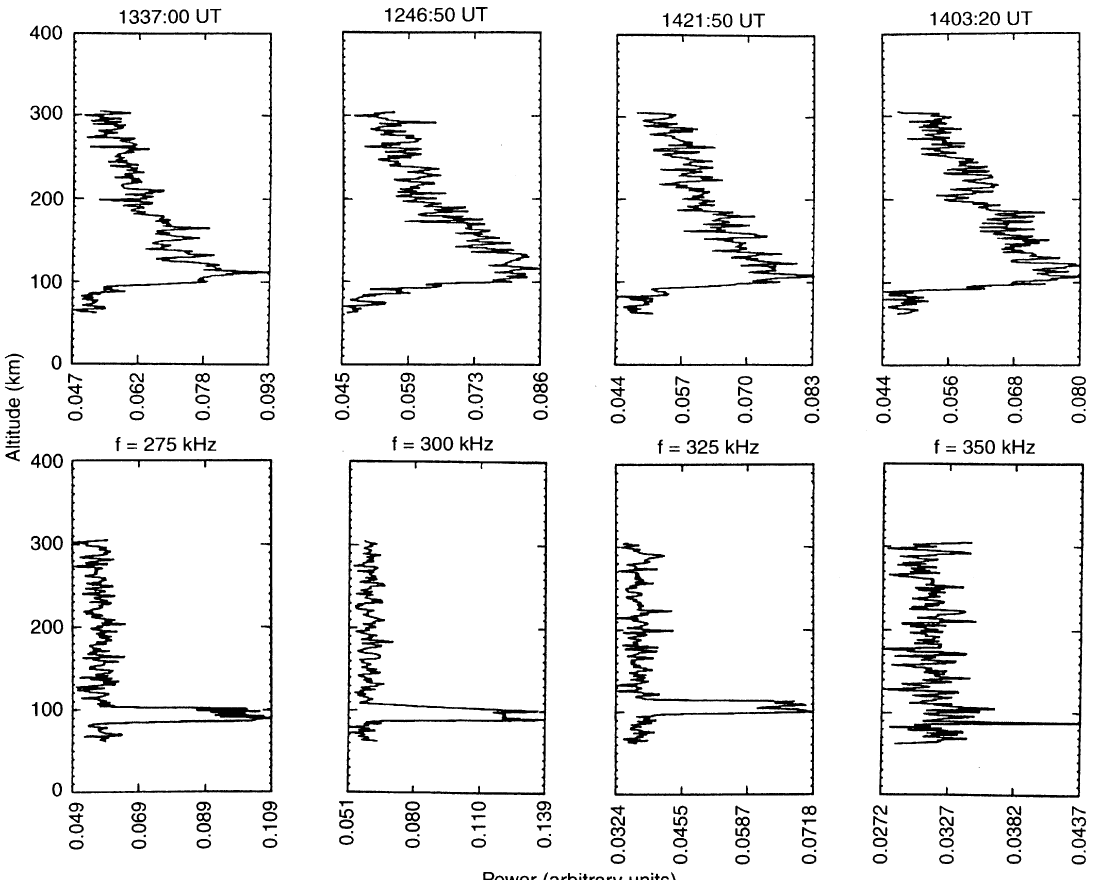
” pper panels : corresponding ion line profiles. Integration time is 10 s in all panels. Power is in arbitrary units